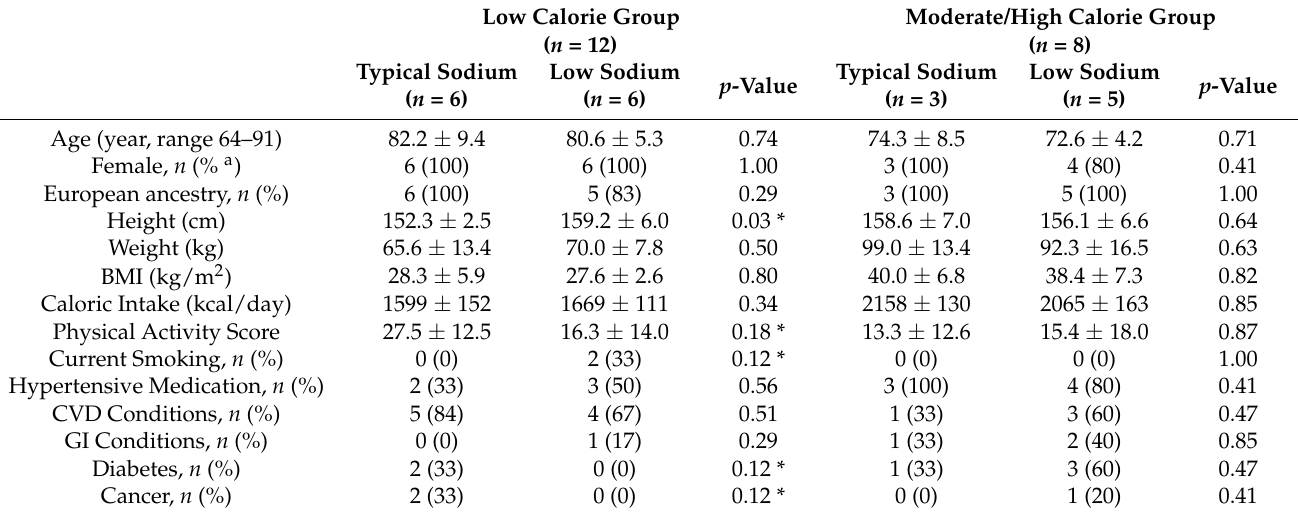
Table 2. Baseline characteristics of SOTRUE participants by meal plan and calorie